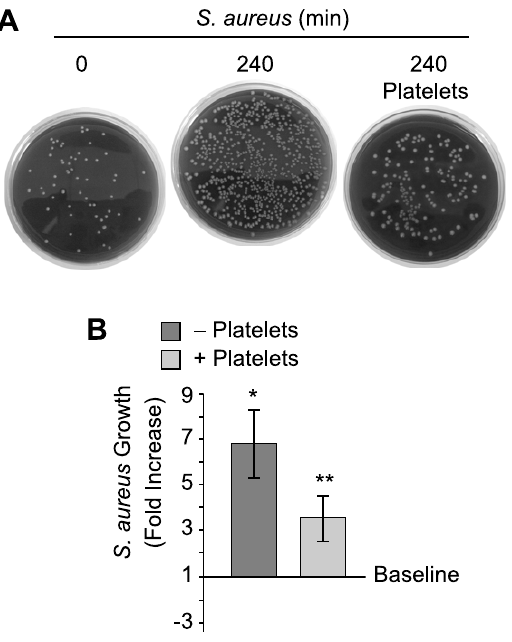
Figure 2. Platelets impede the growth of S. aureus . Cultured S. aureus were incubated in the presence or absence of platelets for 240 minutes and bacterial growth was then measured as described in Materials and Methods. (A) The blood agar plates are representative examples of four independent studies. (B) The bars in the lower panel represent the mean 6 SEM of the fold increase in S. aureus growth (240 minutes) in the presence or absence of platelets over baseline (horizontal line). The single asterisk indicates a significant increase (p , 0.05) in growth over baseline. The double asterisks indicates a significant (p , 0.05) reduction in S. aureus growth in the presence of platelets when compared to S. aureus growth by itself.